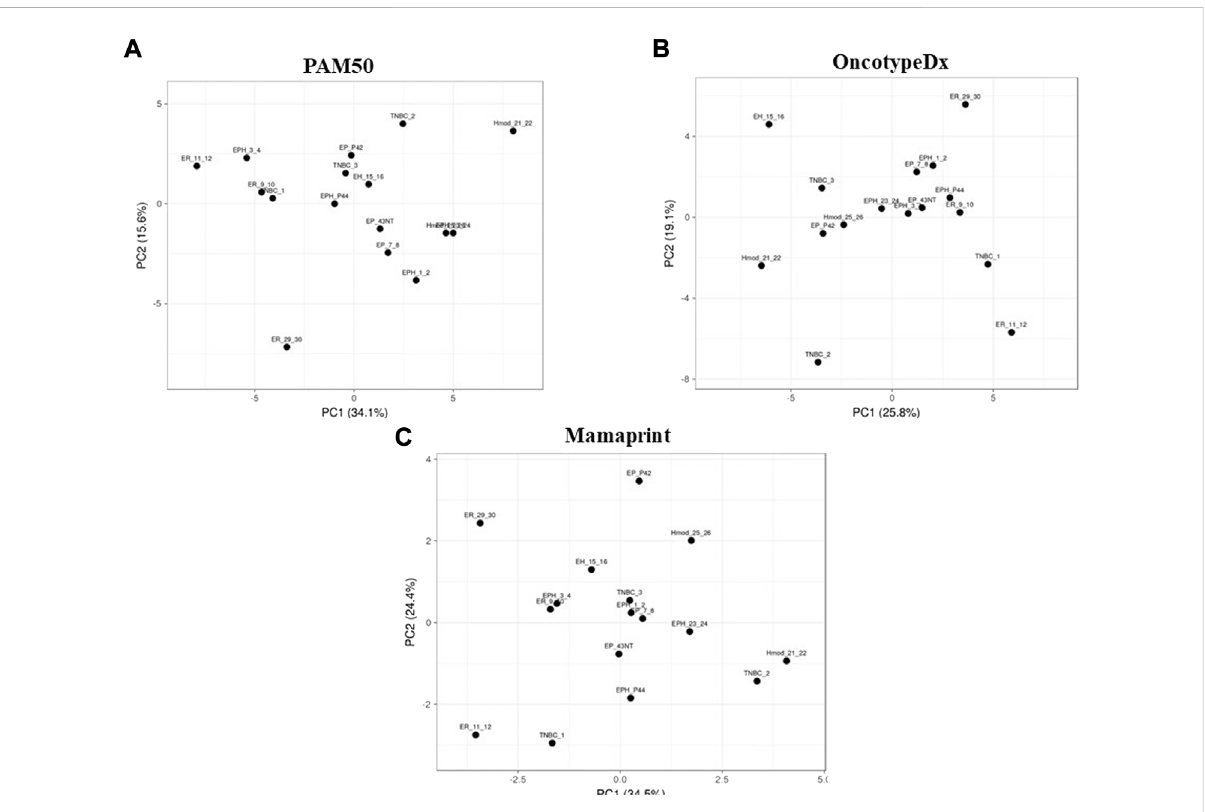
FIGURE 3 Principal component analysis of Indian breast cancer patient samples with the (A) PAM50, (B) MammaPrint, and (C) Oncotype DX gene